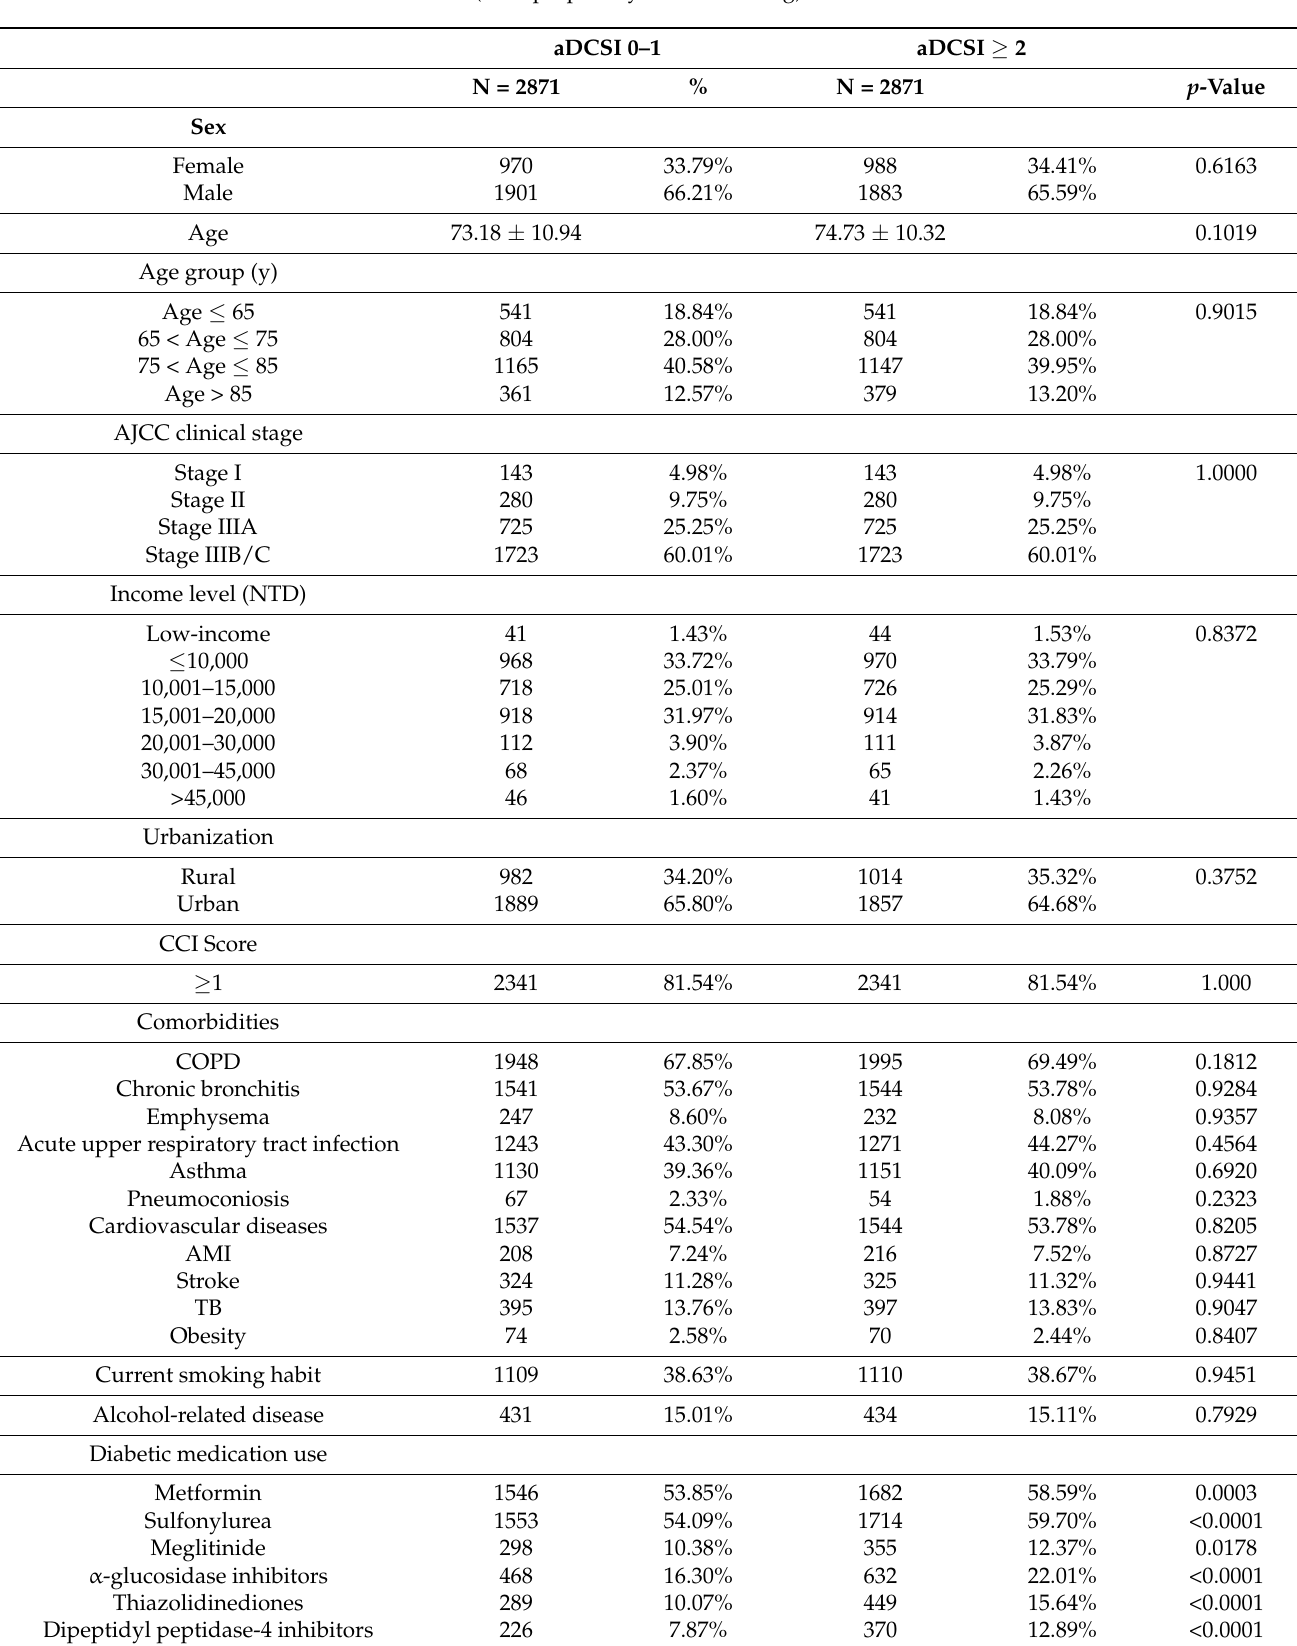
Table 1. Characteristics of patients with both lung squamous cell carcinoma and mild or moderate-to- severe diabetes (after propensity score